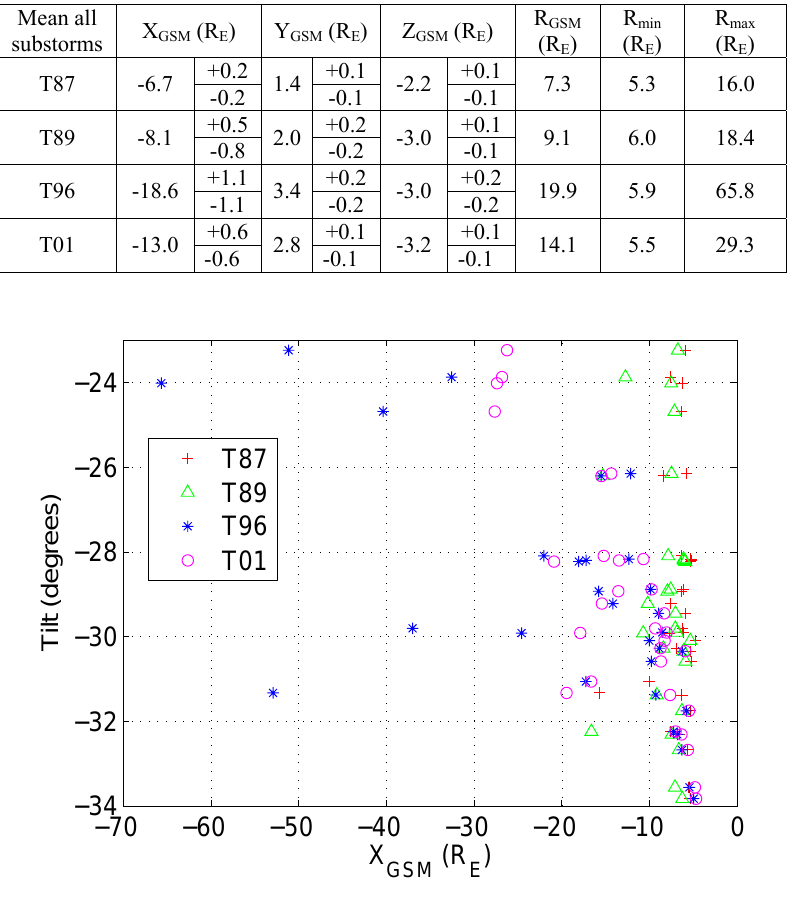
Fig. 10. Dependence of onset location with dipole tilt